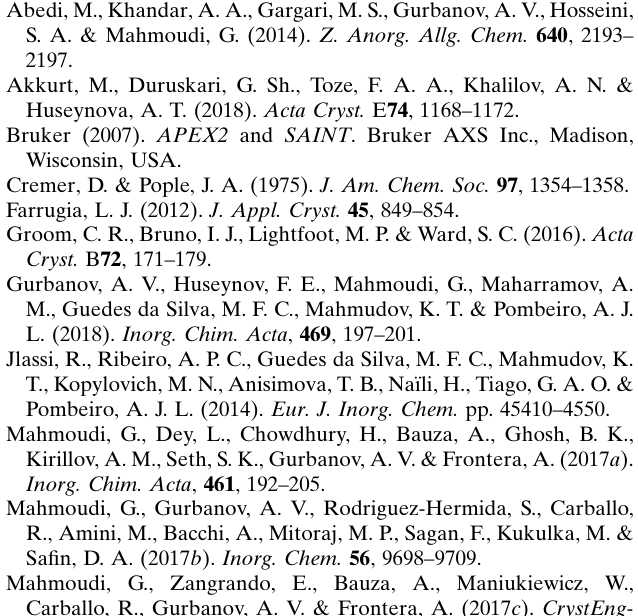
Crystal data Chemical